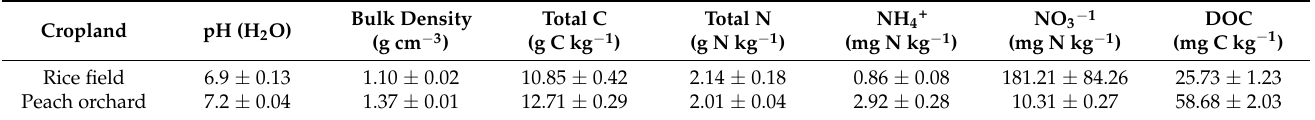
Table 1. The main soil properties in the rice field and transformed peach orchard at a depth of 0–15 cm. Data are means ± standard error ( n =